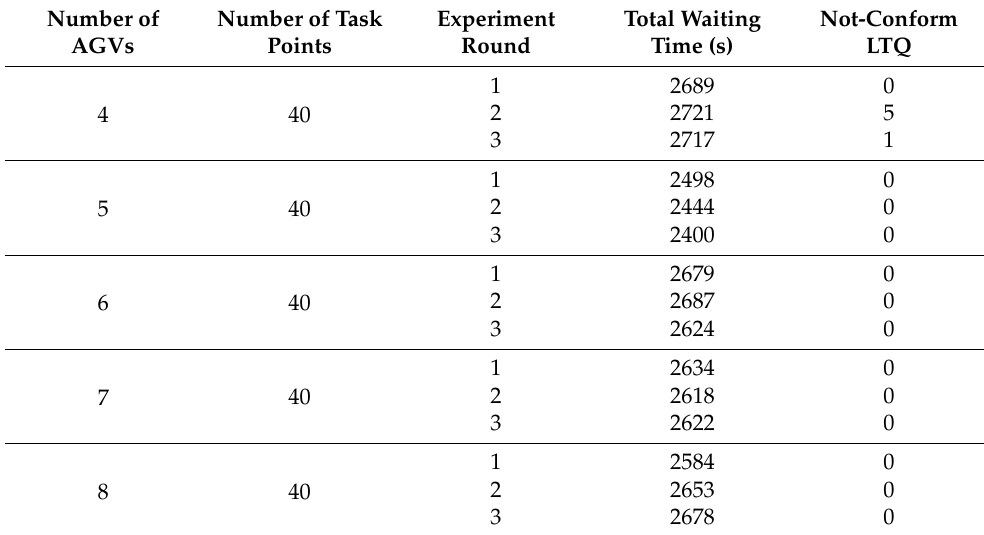
Table 10. The experimental results of different number of AGVs at 40 task points. Number of Number of Task Experiment AGVs Points